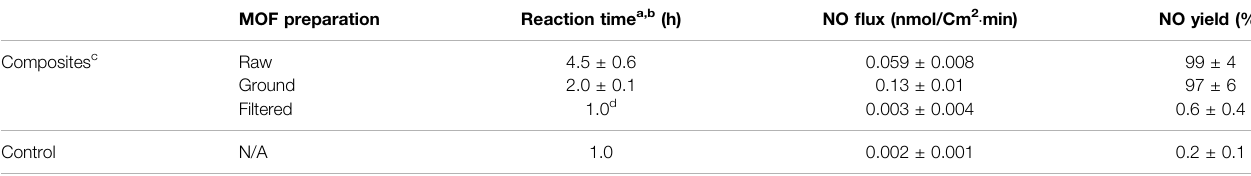
TABLE 2 | Composites comparing three MOF preparation techniques.